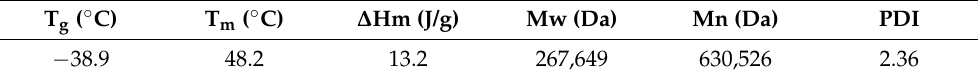
Table 4. Physical properties of mcl-PHA from P. resinovorans using mixed alkane. T g ( ◦ C) T m ( ◦ C) ∆ Hm (J/g) Mw (Da) Mn (Da) PDI − 38.9 48.2 13.2 267,649 630,526 2.36 In addition, Z average (Mz) and Z + 1 average (Mz + 1) molar mass were determined as 1,110,977 and 1,729,603 Da, respectively. The polydispersity index (PDI) was calculated (PDI = Mw/Mn) as 2.36, more or less similar to that of the PHA value of mcl-PHAs biosynthesized by other known Pseudomonas species.